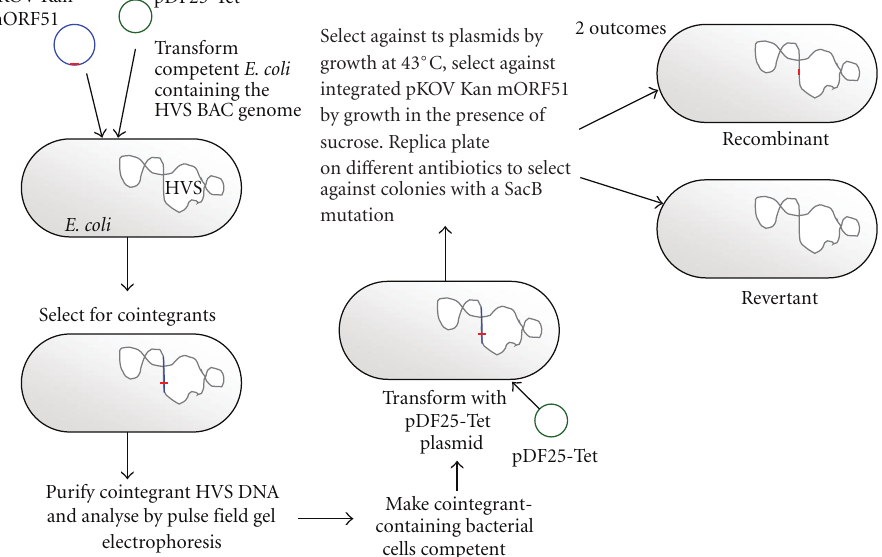
Figure 2: Schematic of the RecA-mediated recombination method used to develop HVS mORF51. Two plasmids are transformed into competent E. coli cells that already harbour the HVS-GFP-BAC genome. These plasmids are both temperature sensitive and have antibiotic resistance markers for ease of selection. The first plasmid, pDF25-Tet, contains a RecA expression cassette to facilitate recombination, as well as a tetracycline resistance gene. The second, pKOV Kan, contains the mutated region of the HVS genome flanked on either side by regions of homology of at least 500 bp. These homology regions target the recombination event to a specific point in the viral DNA. pKOV Kan also contains a SacB gene, allowing negative selection on sucrose-containing medium, and a kanamycin resistance gene. When both plasmids are transformed into the E. coli , RecA expressed from pDF25-Tet induces a recombination event between one of the homology regions in pKOV Kan and the corresponding region in the HVS genome. Clones containing the pKOV Kan plasmid integrated into the HVS genome are then selected and made competent. These cointegrant clones are then retransformed with pDF25-Tet in order to produce a second recombination event. Depending on whether this recombination is in the same or adjacent homology region to the initial recombination, a revertant clone or a recombinant clone will be formed. Selection is used to identify recombinants, which can then be further analysed and confirmed by restriction digest and